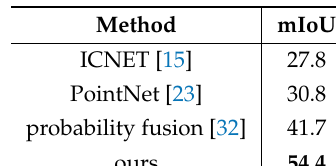
Table 3. Segmentation results of different methods on the Apollo dataset. The bold fonts indicate the best results.